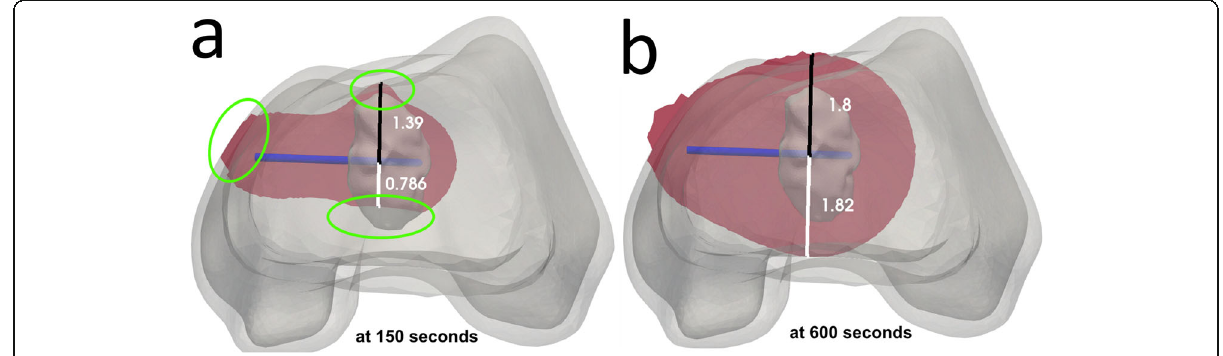
Fig. 6 Progression of the ablation zone of case three with an atypical cartilaginous tumour in the distal femoral metaphysis at two selected times. Both ablation zones are represented as a transversal cut at the height of the electrode, inside the three-dimensional geometry. a The ablation zone after 150 s, when the ablation zone is still rapidly growing. b The ablation zone at the end of the procedure after steady state has been reached. The measurements were taken from the centre of the electrode and perpendicular to it. All measurements are in